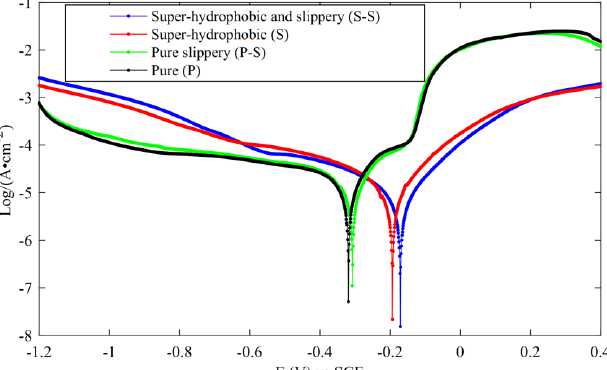
Figure 32. PDP curve (Reprinted with permission from Ref. [47]. 2021, Zhang, L.).